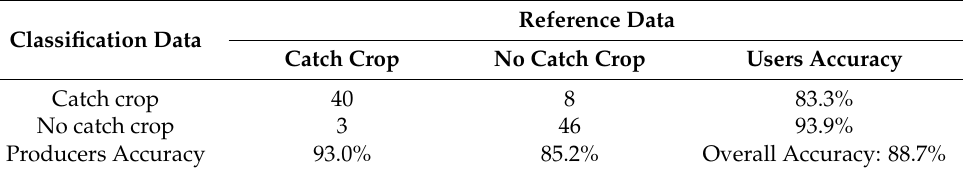
Table 5. Error matrix of compliance evaluation based on cultivation time